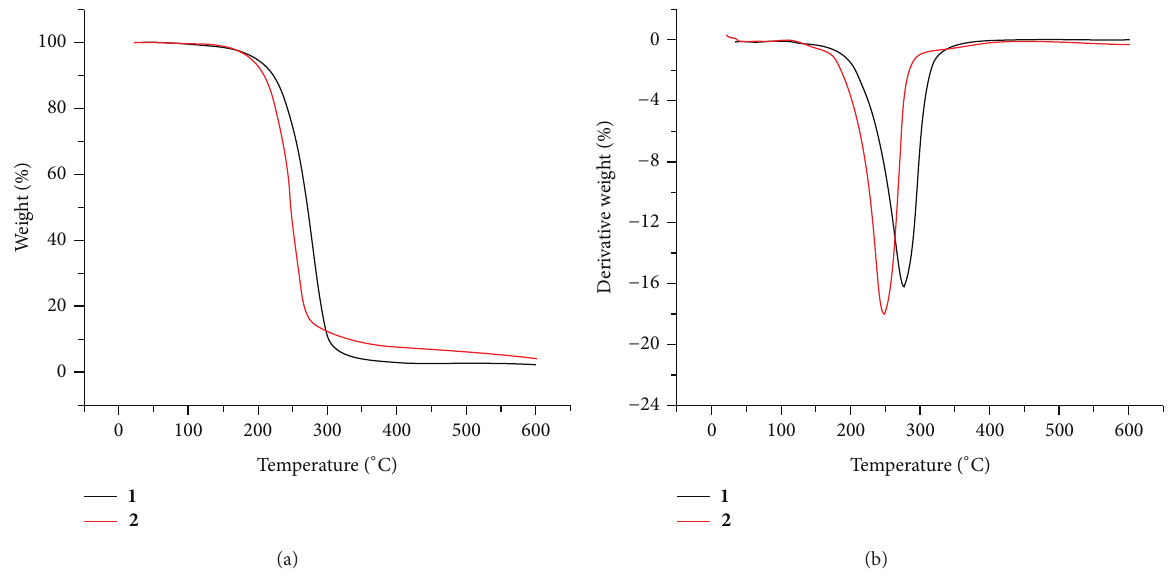
Figure 2: (a) Typical TG curves for compounds 1 and 2 in N 2 atmosphere at 10 ∘ Cmin −1 . (b) Typical DTG curves for compounds 1 and 2 in N 2 atmosphere at 10 ∘ Cmin −1 .